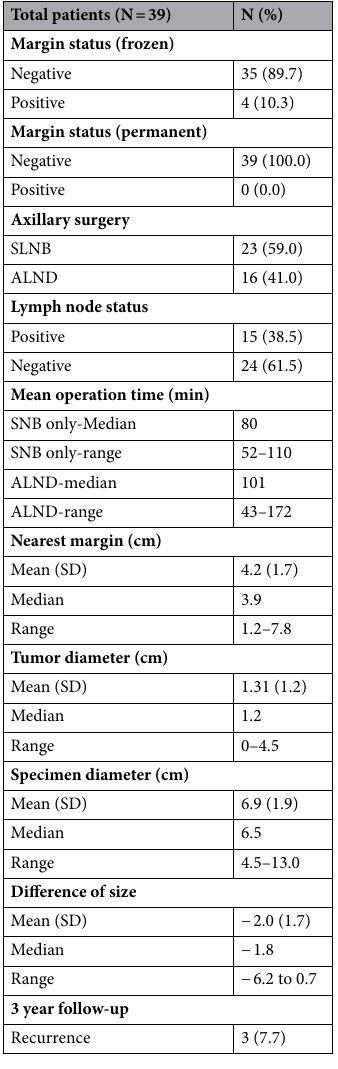
Table 2. Operative pathologic findings and surveillance.